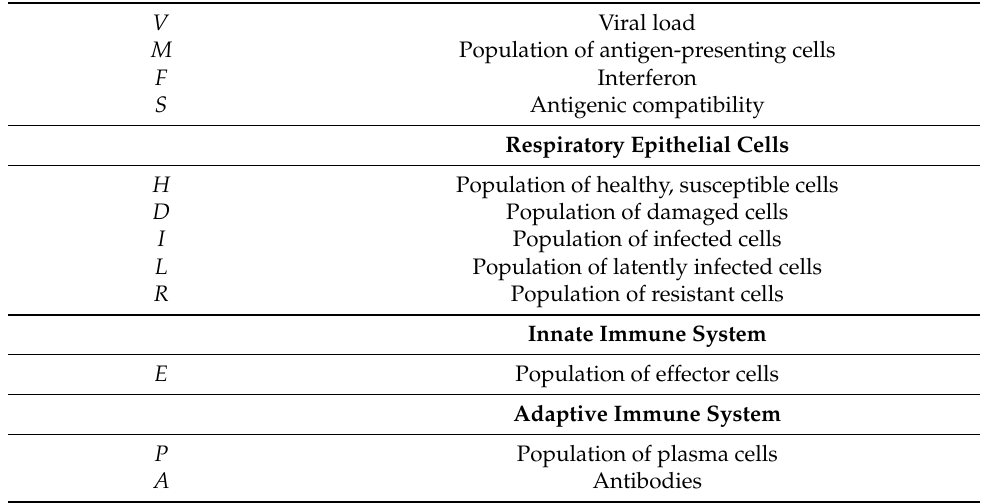
Table 1. The major components of the in-host SARS-CoV-2 infection model with a brief